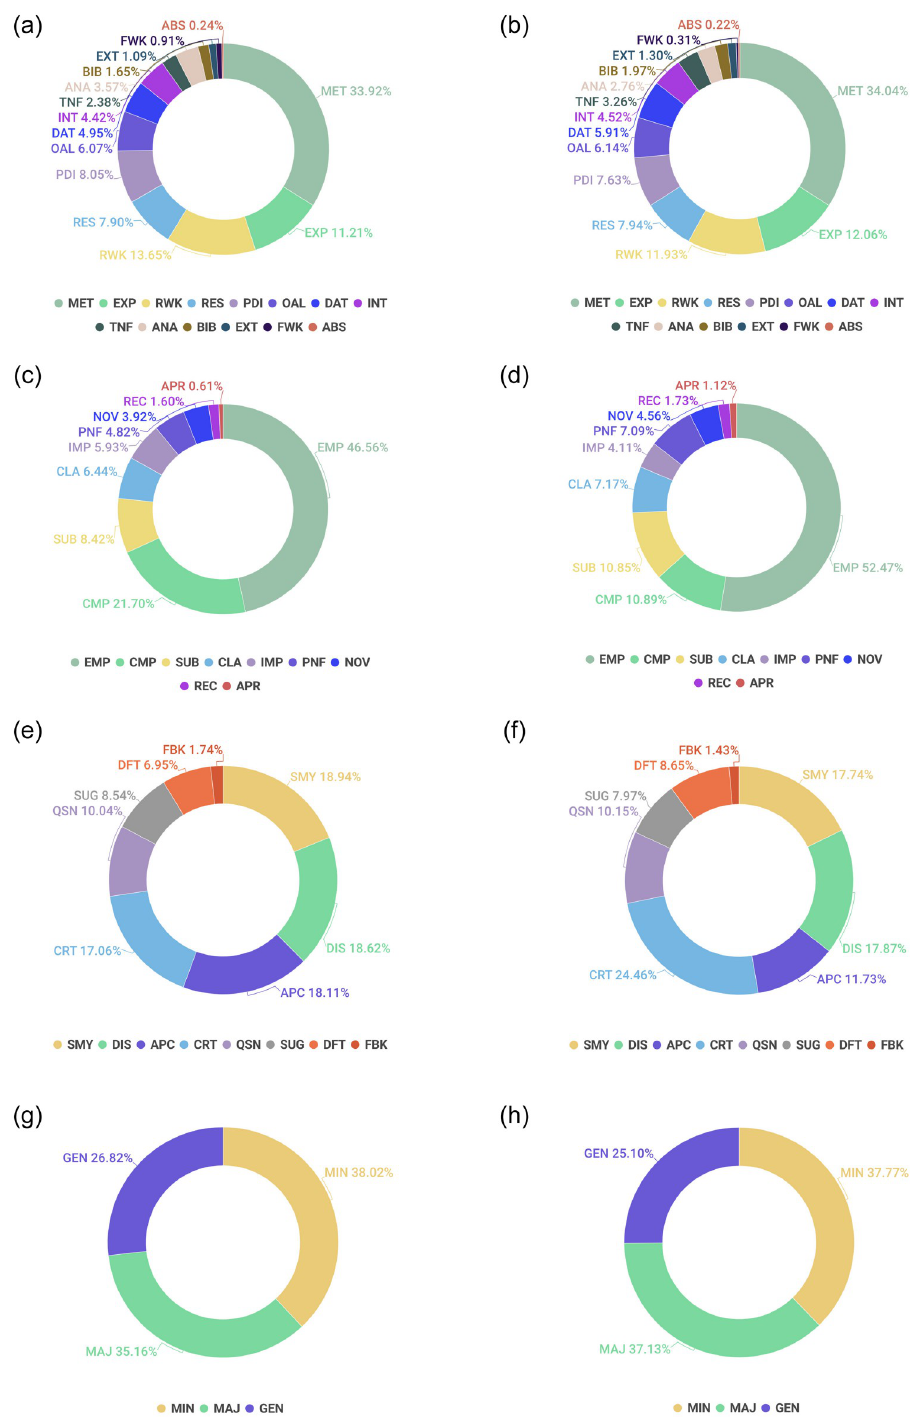
Fig 1. Label distributions for the four layers across peer review analyze. (a) Layer 1-ACC. (b) Layer 1-REJ. (c) Layer 2-ACC. (d) Layer 2-REJ. (e) Layer 3-ACC. (f) Layer 3-REJ. (g) Layer 4-ACC. (h) Layer 4-REJ.